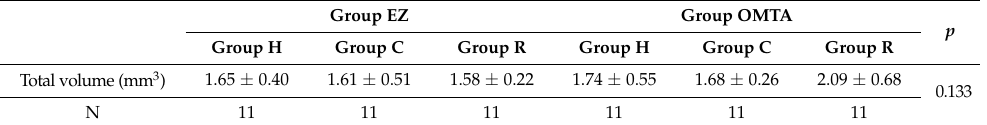
Table 2. Total canal volume (mm 3 ) in apical 5 mm of each group (Mean ± SD).